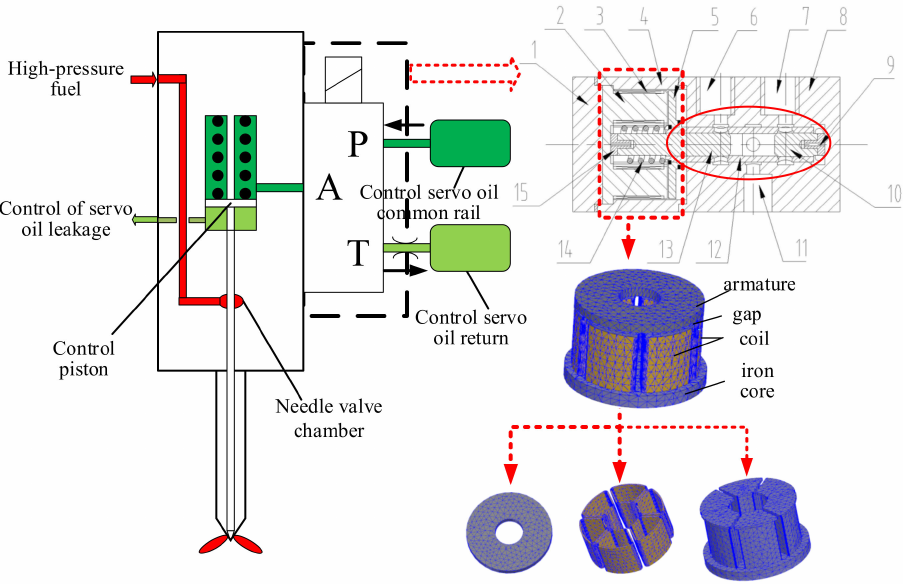
Figure 1. Injector structure diagram. 1—Valve cover; 2—Static core; 3—Valve housing; 4—coil; 5—Armature; 6—Oil inlet; 7—Oil return port; 8—valve body; 9—Right cushion block; 10—Right cone valve element; 11—Control port; 12—Outer valve core; 13—Left cone valve element; 14—Return spring; 15—Left cushion block.